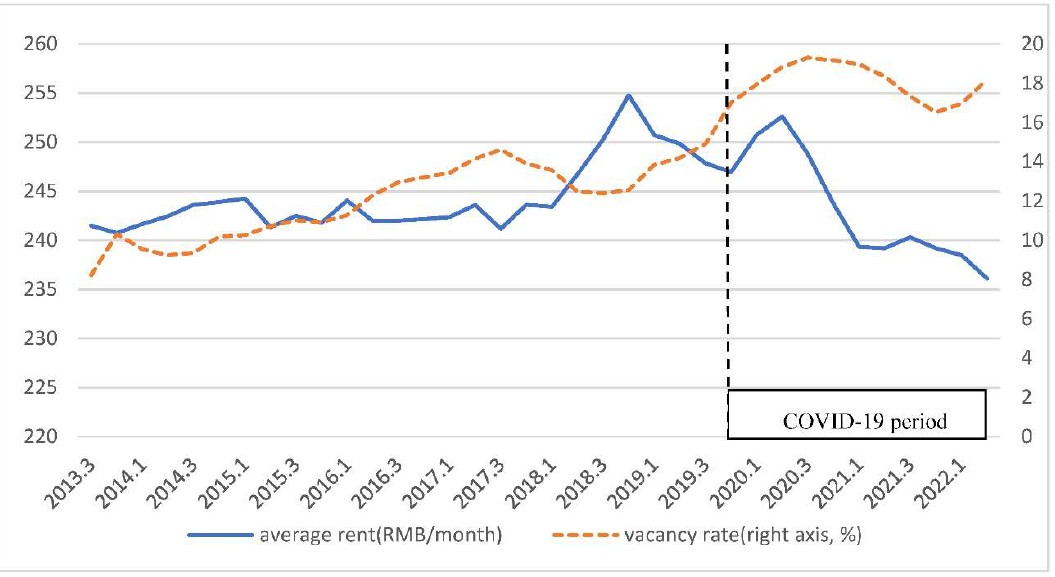
Figure 1. Average Rent and Vacancy Rate (Stock Weighted) of Seven Cities in China (Sources: Savills China, 2022).